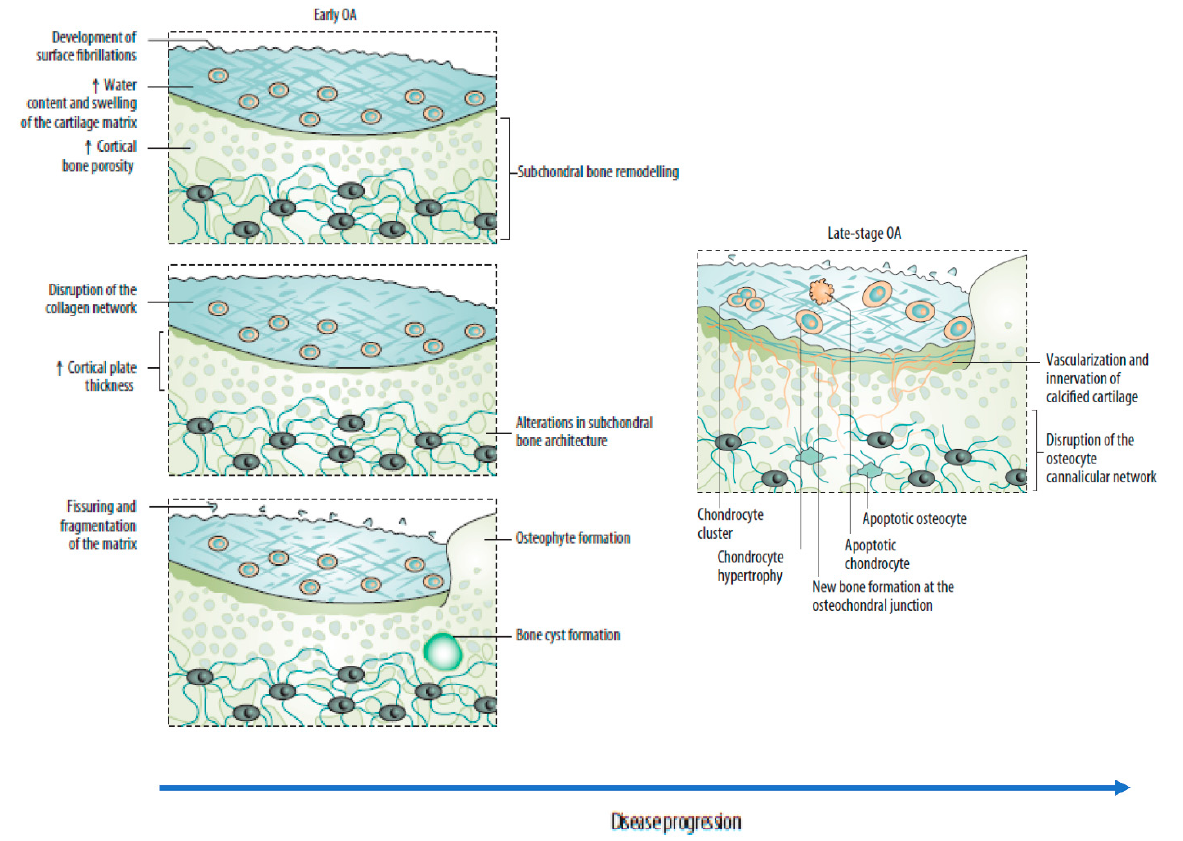
Figure 2. Sequential changes in the osteochondral unit during the evolution of osteoarthritis. ( Left ) Early OA is characterized by increased remodeling of the subchondral bone plate. With disease progression, loss of cartilage matrix proteoglycans and erosion of the collagen network led to the development of deep fissures and delamination of the cartilage, with exposure of the underlying zones of calcified cartilage and subchondral bone. In the subchondral bone, cortical plate thickness gradually increases. ( Right ) Chondrocytes exist mostly in clusters in late-stage OA, but chondrocyte apoptosis is also evident. In the deeper zones, chondrocytes undergo phenotypic alterations, developing features of a hypertrophic phenotype. The calcified cartilage expands and advances into the overlying hyaline articular cartilage, with duplication of the tidemark. This process is initiated by penetrating vascular elements, and accompanying sensory and sympathetic nerves, into the osteochondral junction. OA: osteoarthritis. Source: original.